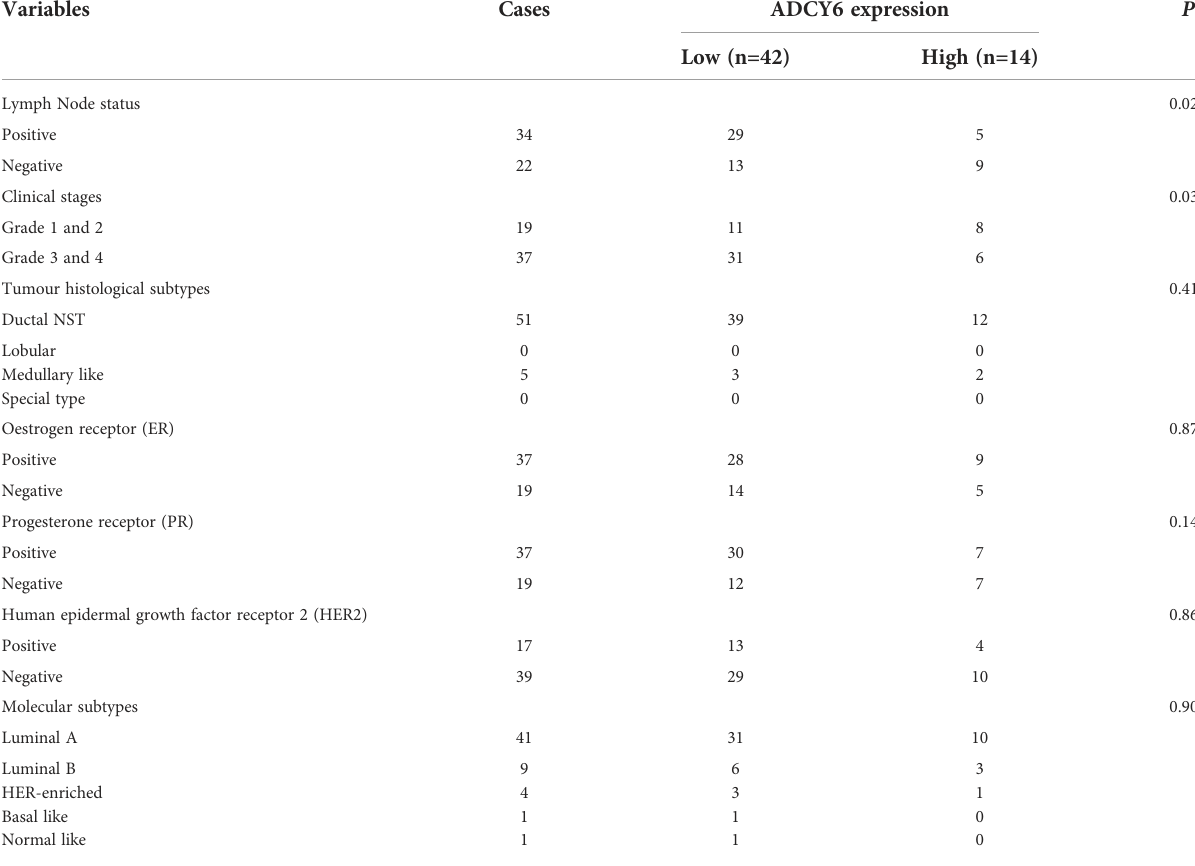
TABLE 1 Association of ADCY6 expression with clinicopathological characteristics in Breast